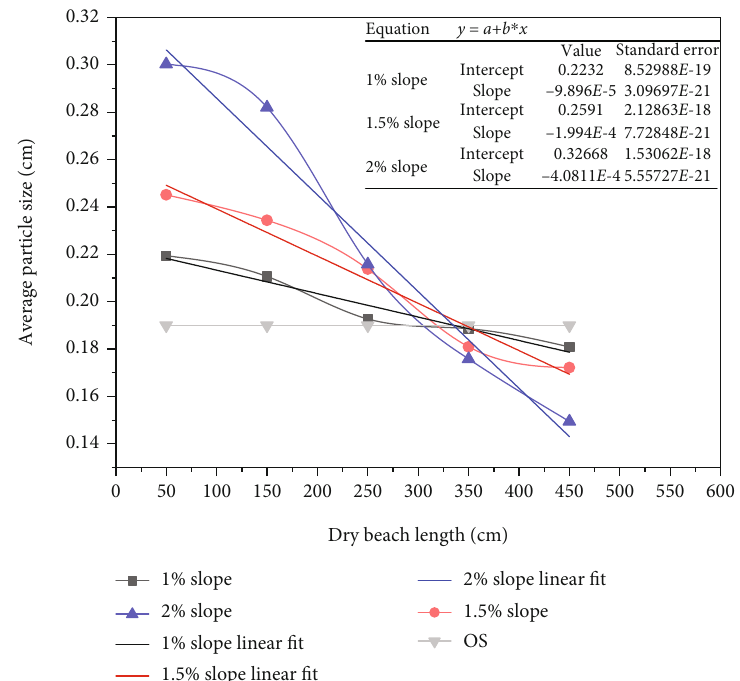
Figure 7: Average particle size distribution along the length of dry beach.